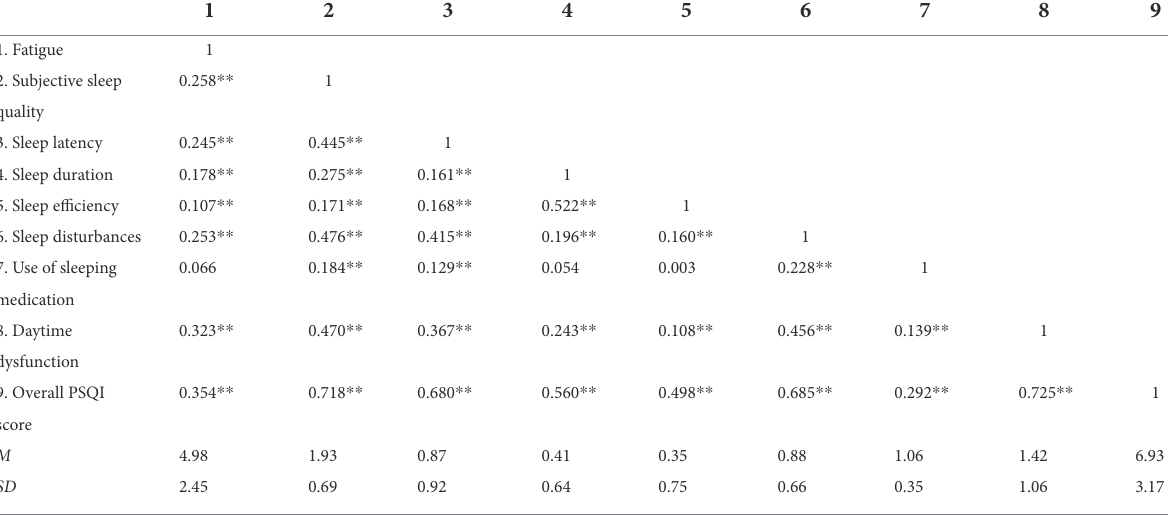
TABLE 4 Means, standard deviations, and correlation coefficient matrix for each variable.